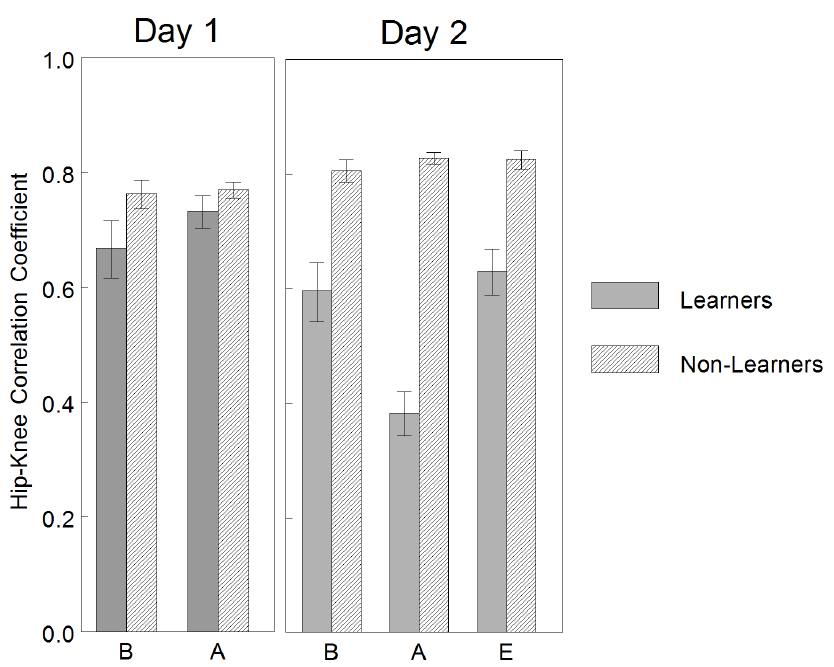
Figure 9. Learners versus non-learners: mean correlation coefficients of hip-knee pair by condition. Between-groups, the Learners in comparison to the Non-Learners did not demonstrate a difference in hip-knee correlation coefficients during any condition of Day 1, but demonstrated a significant decrease in hip-knee correlation coefficients during all conditions of Day 2 (less in-phase hip-knee joint coordination). Within-group, the Learners did not demonstrate a significant decrease in hip-knee correlation coefficients between Day 2 baseline and Day 1 baseline (memory criteria), but did demonstrated a significant decrease in hip-knee correlation coefficients between Day 2 acquisition and Day 1 baseline (learning criteria). Within-group, the Non-Learners did not demonstrate a significant difference in hip-knee correlation coefficients between Day 2 baseline and Day 1 baseline (memory criteria) or Day 2 acquisition and Day 1 baseline (learning criteria). This can be interpreted as the Learner group learned to generate less in-phase hip-knee joint coordination when interacting with the mobile on Day 2 as compared to baseline kicking on Day 1. The Non-Learner group did not demonstrate a change in hip-knee coordination across days. Error bars are standard error. B=baseline, A=acquisition, E=extinction.